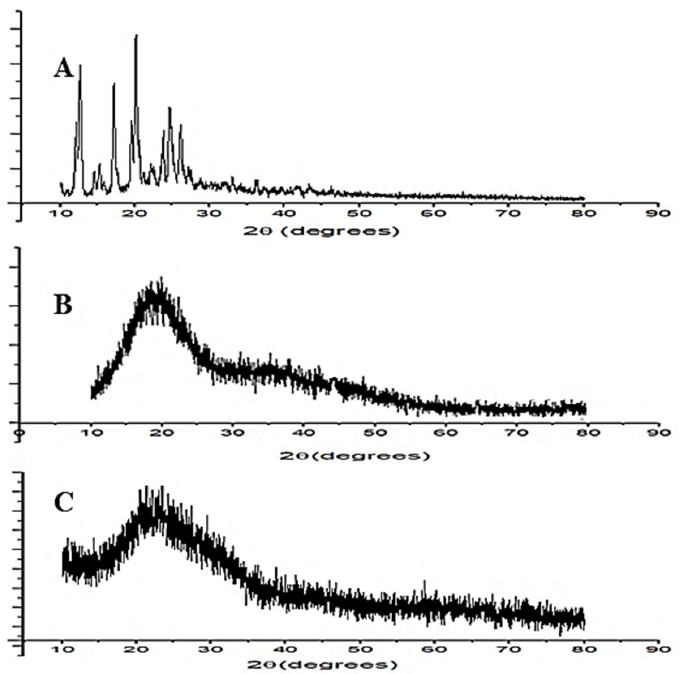
Figure 7. X ‐ ray diffraction spectra of ( A ) pure EZL, ( B ) maltodextrin and ( C ) EZL ‐ PNsopt. Figure 7. X-ray diffraction spectra of ( A ) pure EZL, ( B ) maltodextrin and ( C )